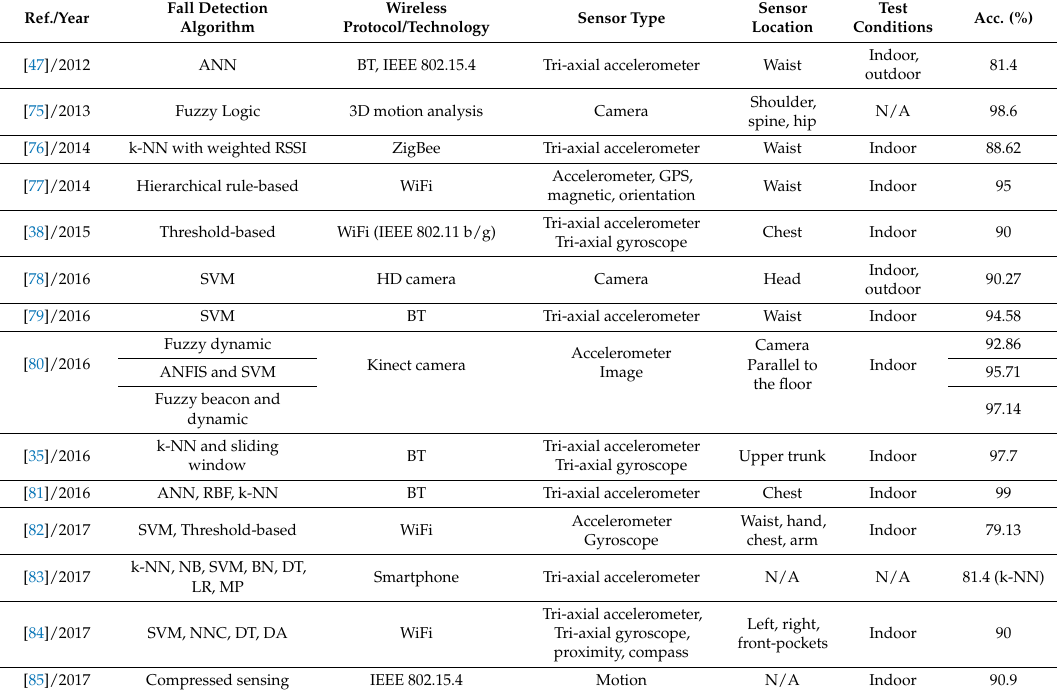
Table 4. Comparison Between the accuracy of the adopted ANN technique and fall detection algorithms in previous